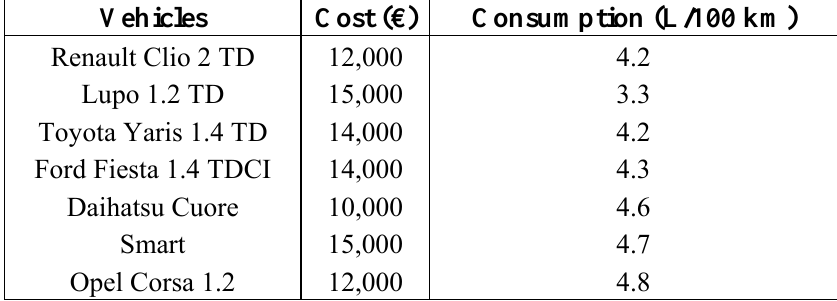
Table 13. Costs and consumption of some petrol and Diesel vehicles [13].